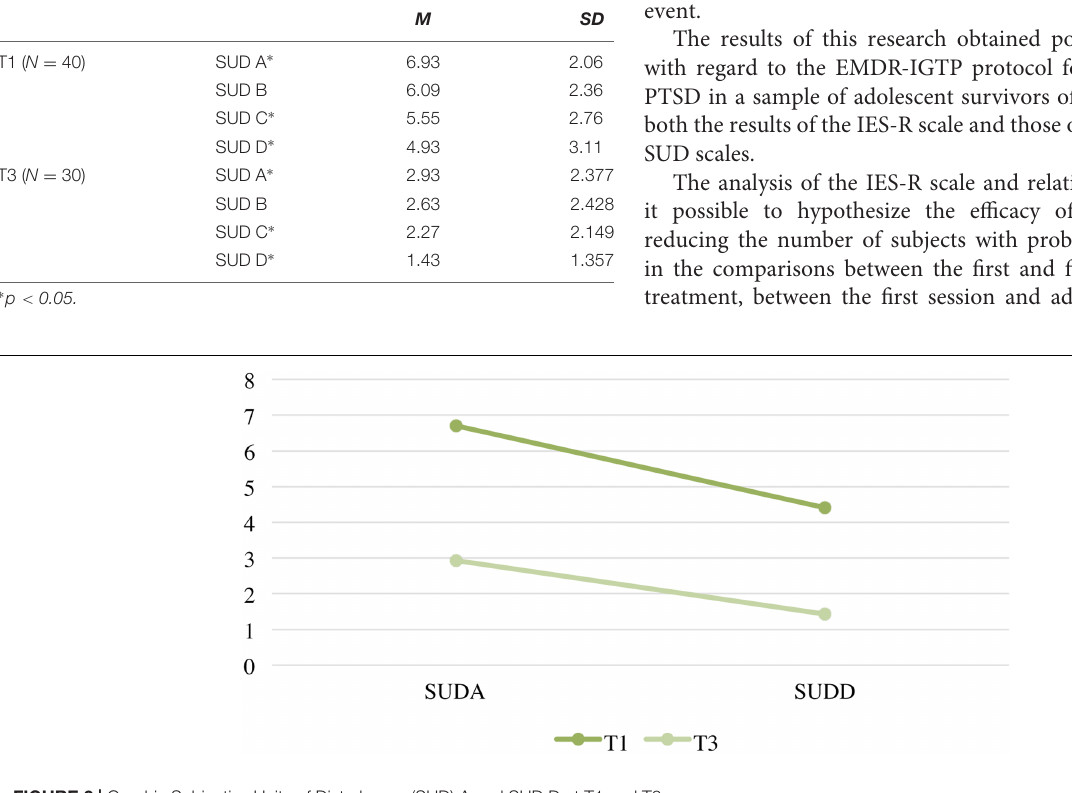
FIGURE 2 | Graphic Subjective Units of Disturbance (SUD) A and SUD D at T1 and